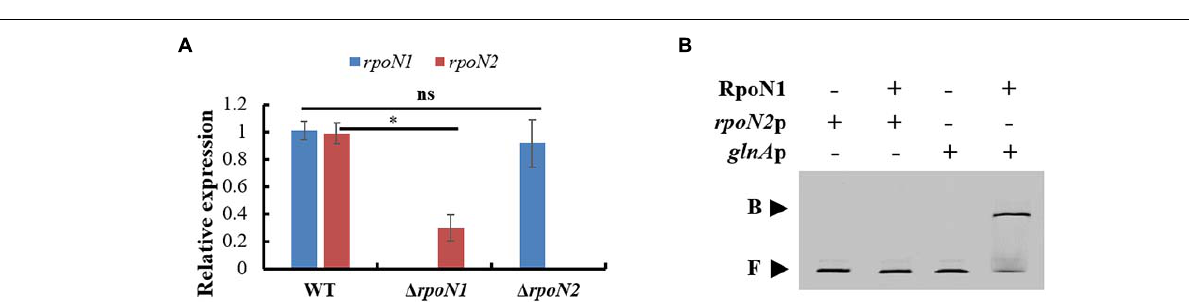
( Figure 6 ). The outcomes of this study suggested that RpoN1 and RpoN2 might regulate the bacterial swimming motility and virulence in Xoo by regulating the expression of flagellar synthesis genes and flgRR ,